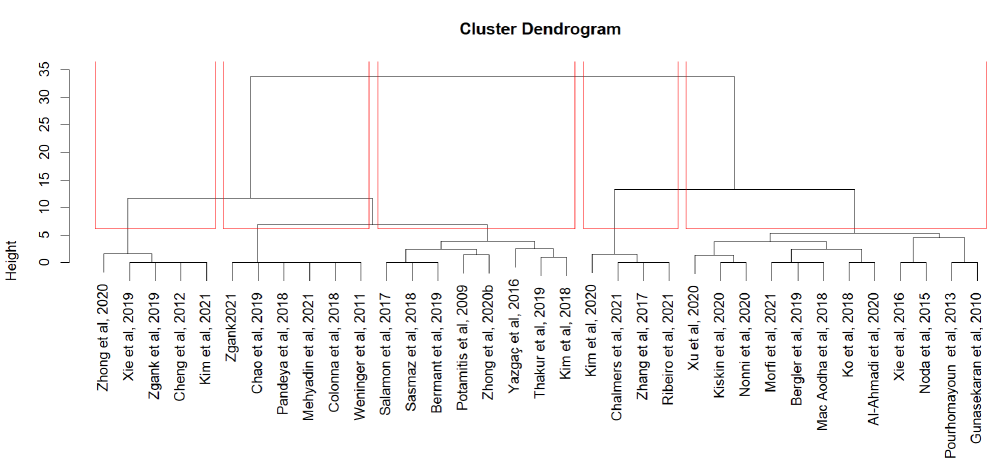
Figure 17. Associations between pre-processing and classification techniques for bioacoustics studies.